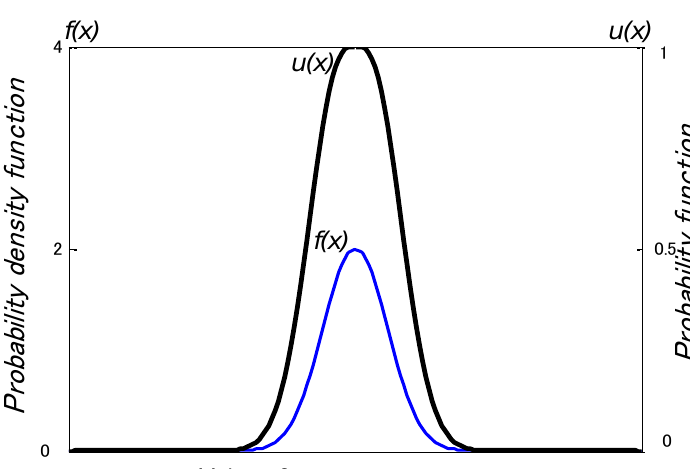
Figure 5. Possibility and probability density